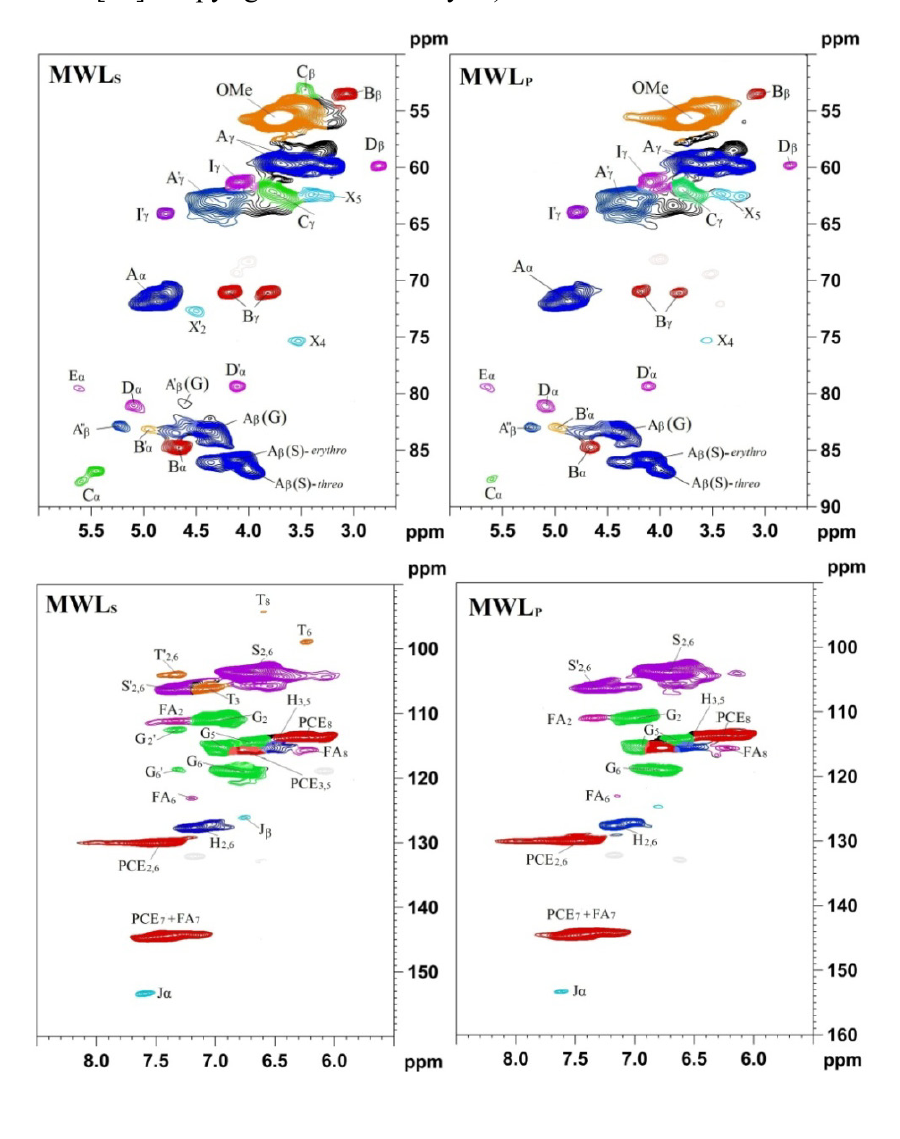
, S , represents MWL extracted from P